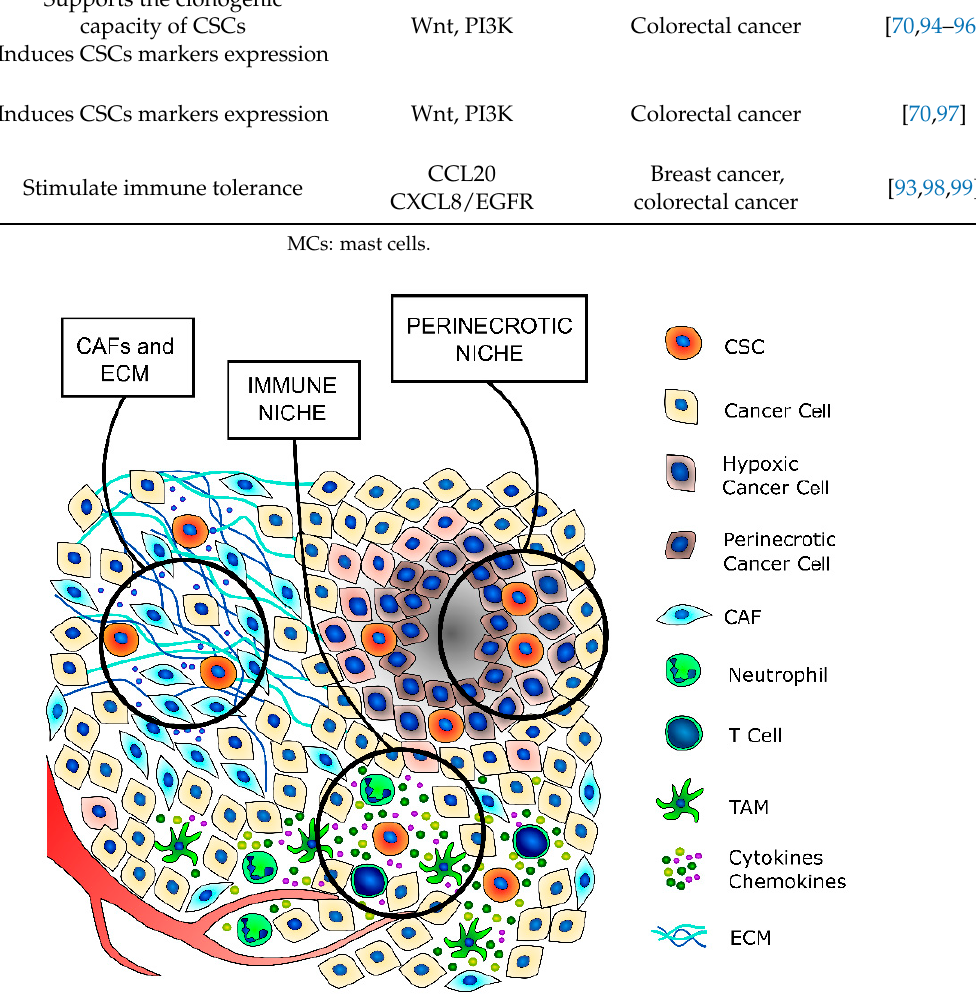
Figure 2. TC stem cell niches. CSCs principally exist in tumor areas with specific microenvironmental conditions, the so-called stem cell niches. The cancer-associated fibroblasts (CAFs) secrete a thicker extracellular matrix (ECM) and different prostemness soluble factors that induce the acquisition of a stem-like phenotype by cancer cells and promote and support the survival and self-renewal abilities of already existing CSCs. The immune niche is composed of all the different